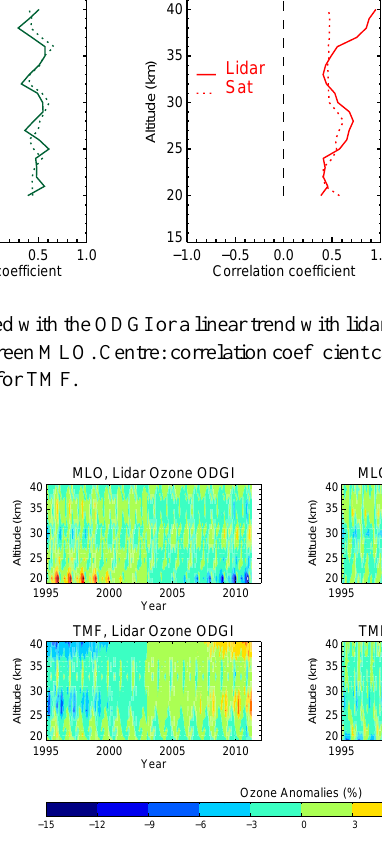
Fig. 11. 2-D contours of the ozone ODGI response reconstructed from the regression analysis applied to lidar and satellite data. Cor- relation coefficients calculated between lidar and satellite responses are indicated on the right-hand